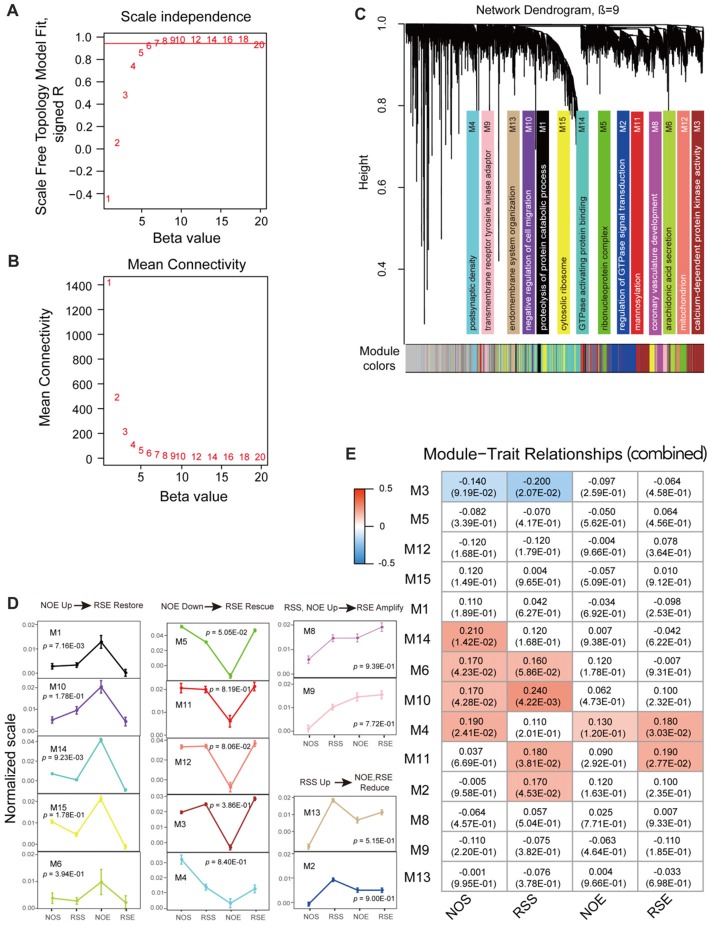
Co-expression module analyses. (A) The soft thresholding index R2 (y-axis) as a function of different powers β (x-axis). (B) The mean connectivity (y-axis) is a strictly decreasing function of the power β (x-axis). (C) Fourteen co-expression modules identified from the combined dataset. WGCNA cluster dendrogram groups genes (n = 6413) measured across BXD Hippocampus into distinct gene modules (M1–14) defined by dendrogram branch cutting. These modules were significantly enriched for gene ontologies linked to discrete cellular functions and/or organelles in the brain. Genes that did not belong to any modules were housed in the gray modules. The gray gene modules were ignored in this study. (D) Four expression patterns. Four expression patterns were found: up-regulation in No restraint stress and given an ethanol injection (NOE) but restoration in Restraint stress followed by an ethanol injection (RSE) (NOE Up→RSE Restore); down-regulation in NOE but rescue in Restraint stress followed by an ethanol injection (NOE Down→RSE Rescue); up-regulation in both Restraint stress followed by a saline injection (RSS) and NOE, and further amplification in RSE (RSS, NOE Up→RSE Amplify); up-regulation in RSS but reduction in NOE and RSE (RSS Up→NOE, RSE Reduce). One-way analysis of variance (ANOVA) was used to determine the conditions which are significantly different from each other for each expression pattern. ANOVA p-values are indicated in each pattern. The error bar represents standard error of the mean (SEM). (E) Heat maps of Pearson correlation and p-value between modules and traits. Each cell represents the correlation coefficient (and p-value) computing from correlating module eigengenes (MEs) (rows) to traits (columns). Only those correlations with |p| < 0.1 are shown.